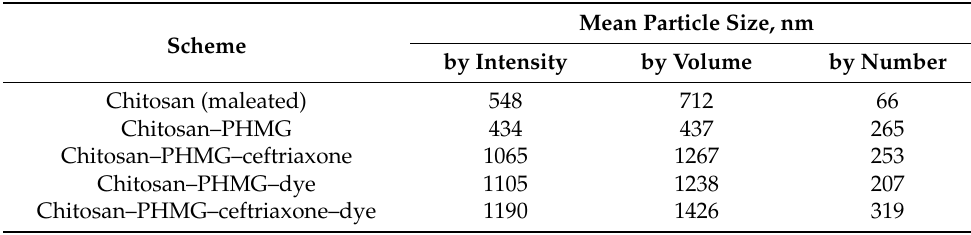
Table 2. Particle sizes obtained by dynamic light scattering technique in 7 mM phosphate buffer solution (pH 7.4). Mean Particle Size, nm Scheme by Intensity by Volume by